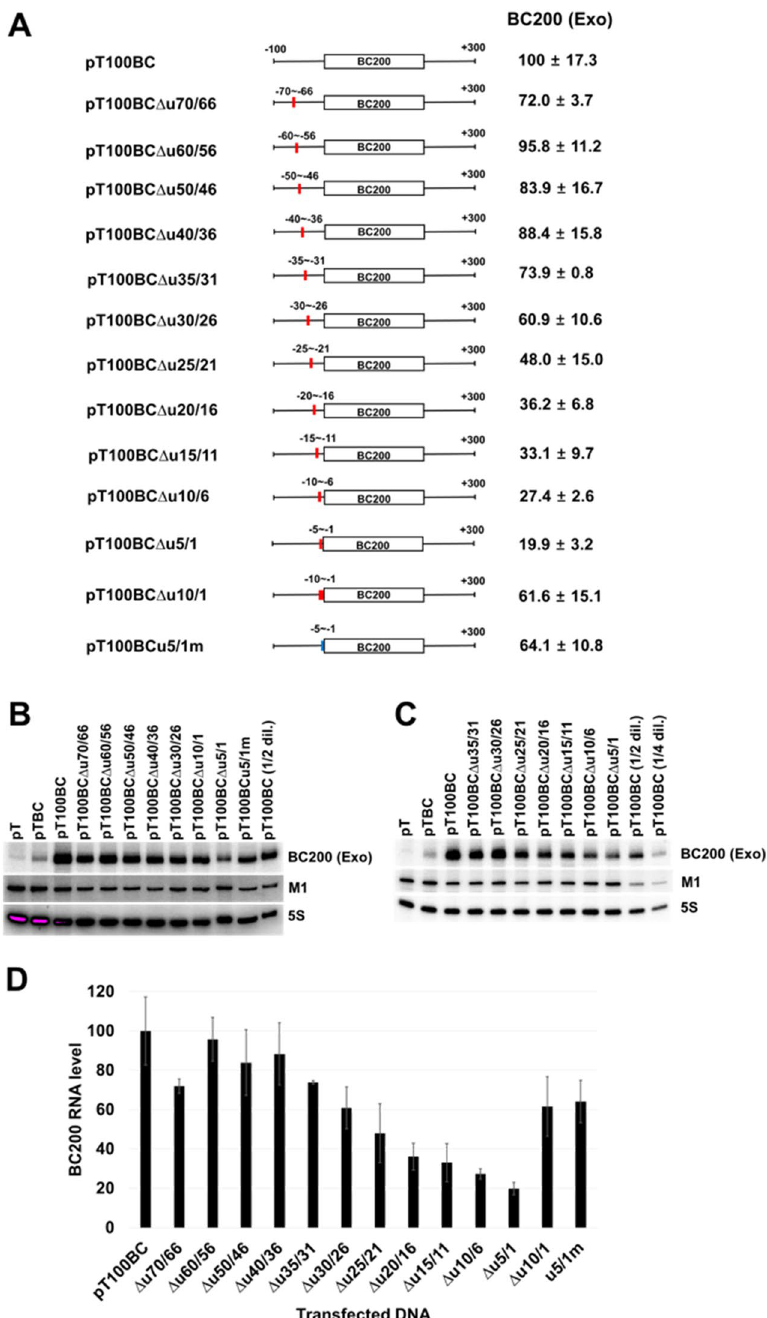
Figure 3. Effects of 5-bp deletions within the − 100 upstream sequence of the BC200 RNA gene. ( A ) Schematic representation of constructs containing deletion or mutation in the 5 ′ upstream sequences and their relative expression levels. The 5-bp or 10-bp deleted regions are indicated by the red boxes in the sequence upstream of the − 100 upstream constructs. The deletion points are indicated by number/number following after ∆ u, such as pT100BC ∆ u5/1 (deletion from − 5 to − 1). The mutation of positions − 5 to − 1 in mutation derivative pT100BCu5/1m is shown by the blue box. ( B and C ) The deleted or mutated constructs were introduced into HeLa cells, and the relative expression levels of exogenous BC200 RNA were calculated by dividing their Northern blot signals by those of the M1 RNA after both sets of signals were normalized with respect to those of the 5S rRNA. The ratio of expression from deletion or mutation derivatives to that from the parental pT100BC is presented in Panels A and D. The cells were transfected with 1 µ g of plasmids expressing BC200 RNA and 1 µ g of the M1 RNA expressing plasmid. Exogenous BC200 RNA signals were corrected by subtracting the endogenous signal obtained in cells transfected with the control vector. The 1/2 and 1/4 dilution (1/2 dil. and 1/4 dil., respectively) of total cellular RNA were used for a semi-standard curve. ( D ) The bar graph represents the relative expression levels of exogenous BC200 RNA. BC200 (Exo), exogenous BC200